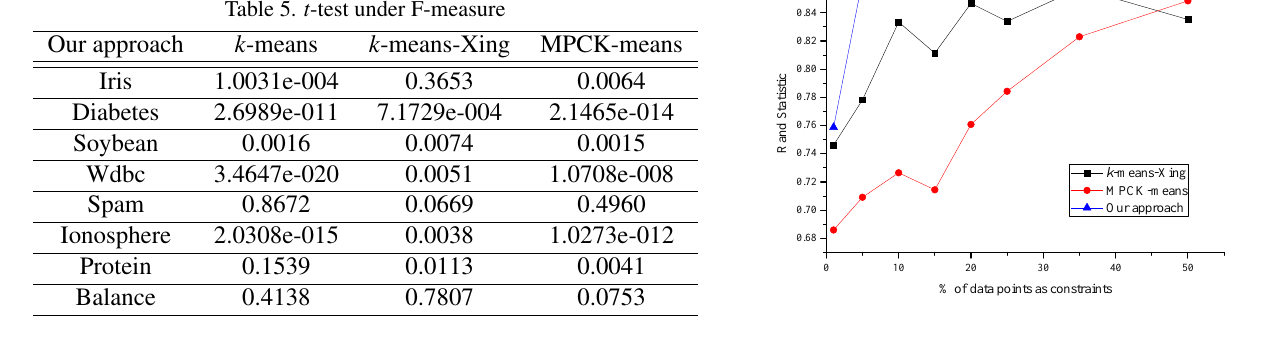
Fig. 5. Clustering accuracy versus constraints on